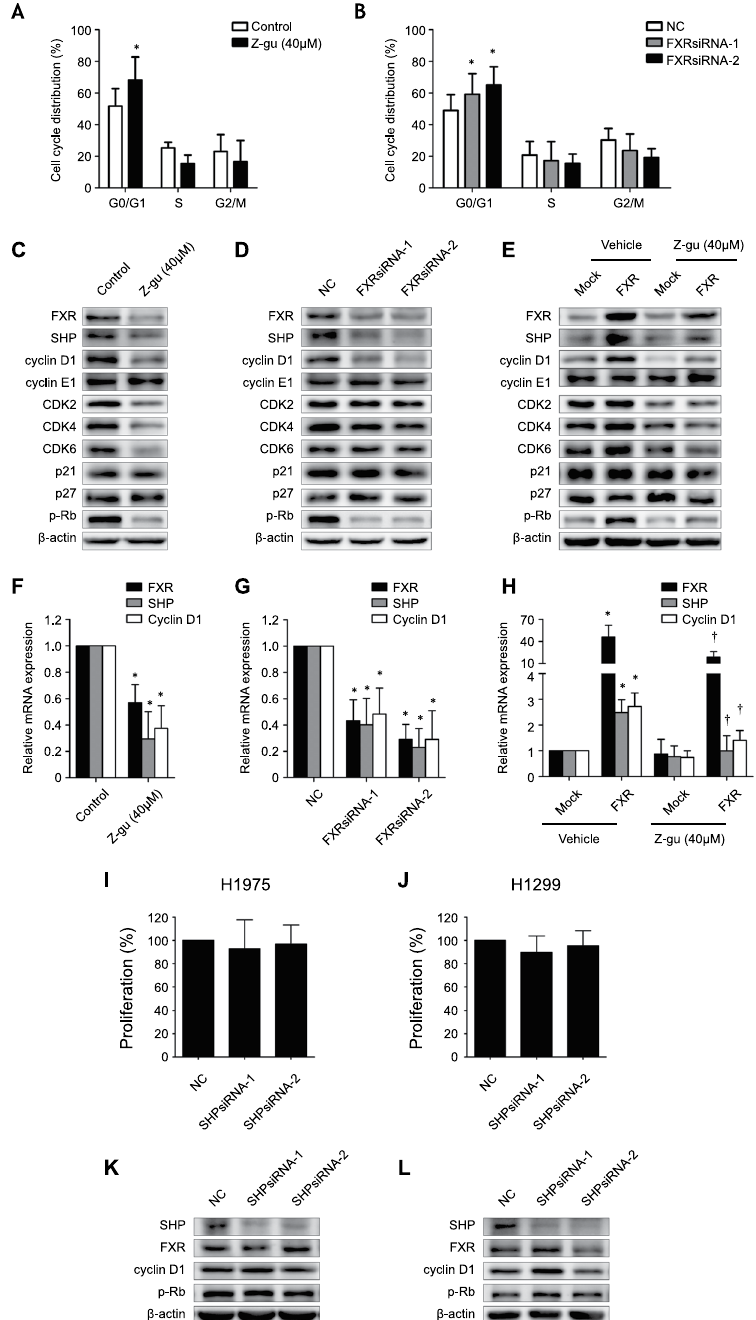
Figure 4. Effects of FXR on cell cycle distribution and cell cycle regulators, independent of SHP in NSCLC. The cell cycle profile of H1975 cells was analyzed by flow cytometry two days after treatment with Z-guggulsterone (Z-gu, 40 μ M) ( A ), or transfection with NC- or FXR-siRNA sequences ( B ). Western blot analysis was performed to evaluate the expression of FXR, SHP, cyclin D1, cyclin E1, CDK2, CDK4, CDK6, p21 Cip1 , p27 Kip1 , and p-Rb in H1975 cells that were treated with Z-guggulsterone (40 μ M) ( C ) or transfected with NC- or FXR-siRNA sequences ( D ) as well as in HCC4006 stable cell lines that were treated with Z-guggulsterone (40 μ M) ( E ). Quantitative RT-PCR was performed to evaluate the FXR, SHP, and cyclin D1 mRNA abundance in H1975 cells that were treated with Z-guggulsterone (40 μ M) ( F ) or transfected with NC- or FXR-siRNA sequences ( G ) as well as in HCC4006 stable cell lines that were treated with Z-guggulsterone (40 μ M) ( H ). The cell proliferation rate of H1975 ( I ) and H1299 ( J ) cells was determined by the SRB assay three days after transfection with NC- or SHP-siRNA sequences. Western blot analysis was performed to evaluate the expression of SHP, FXR, cyclin D1, and p-Rb in H1975 ( K ) and H1299 ( L ) cells that were transfected with NC- or SHP-siRNA sequences. The data are presented as the mean ± SD of at least three independent experiments. * p < 0.05, compared with the control, NC, or mock group, respectively; † p < 0.05, compared with the FXR-overexpressed HCC4006 cell